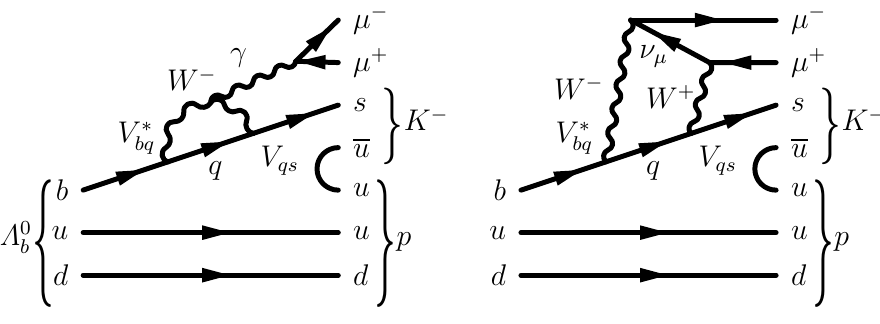
Figure 1 . Diagrams for the decay (cid:3) 0 pK (cid:0) (cid:22) + (cid:22) (cid:0) , in which V bq and V qs are CKM matrix elements b ! and q represents one of the three up-type quarks u , c or t , the t -quark contribution being dominant. The uu pairs originate from the hadronization